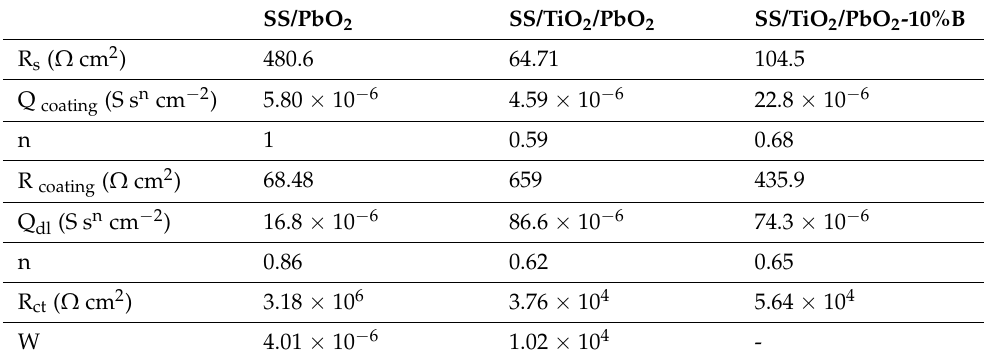
Table 2. EIS parameters obtained from fitting the electrical equivalent circuit on the